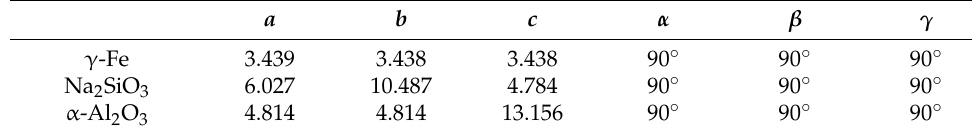
Figure 1. The crystal structure of ( a ) γ -Fe, ( b ) Na 2 SiO 3 , and ( c ) α -Al 2 O 3 .